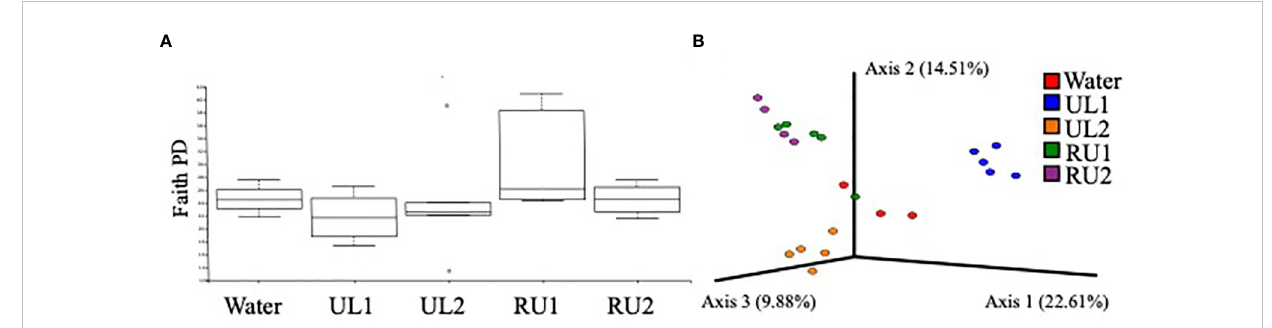
FIGURE 5 (A) Alpha diversity plot showing the mean fungal phylogenetic diversity by treatment. No signi fi cant differences in Faith PD index were observed between treatments (Kruskal-Wallis H= 4.710, p= 0.318). (B) PCOA plot showing fungal community composition dissimilarity between treatments (based on Bray-Curtis distance) at the end of the experiment (144h after the second application). Fungi composition signi fi cantly differed between treatments (PERMANOVA Pseudo-F= 3.927, p= 0.001). ASV tables were rari fi ed to 20000 sequences per sample, so samples that did not reach that sequencing depth were excluded from the